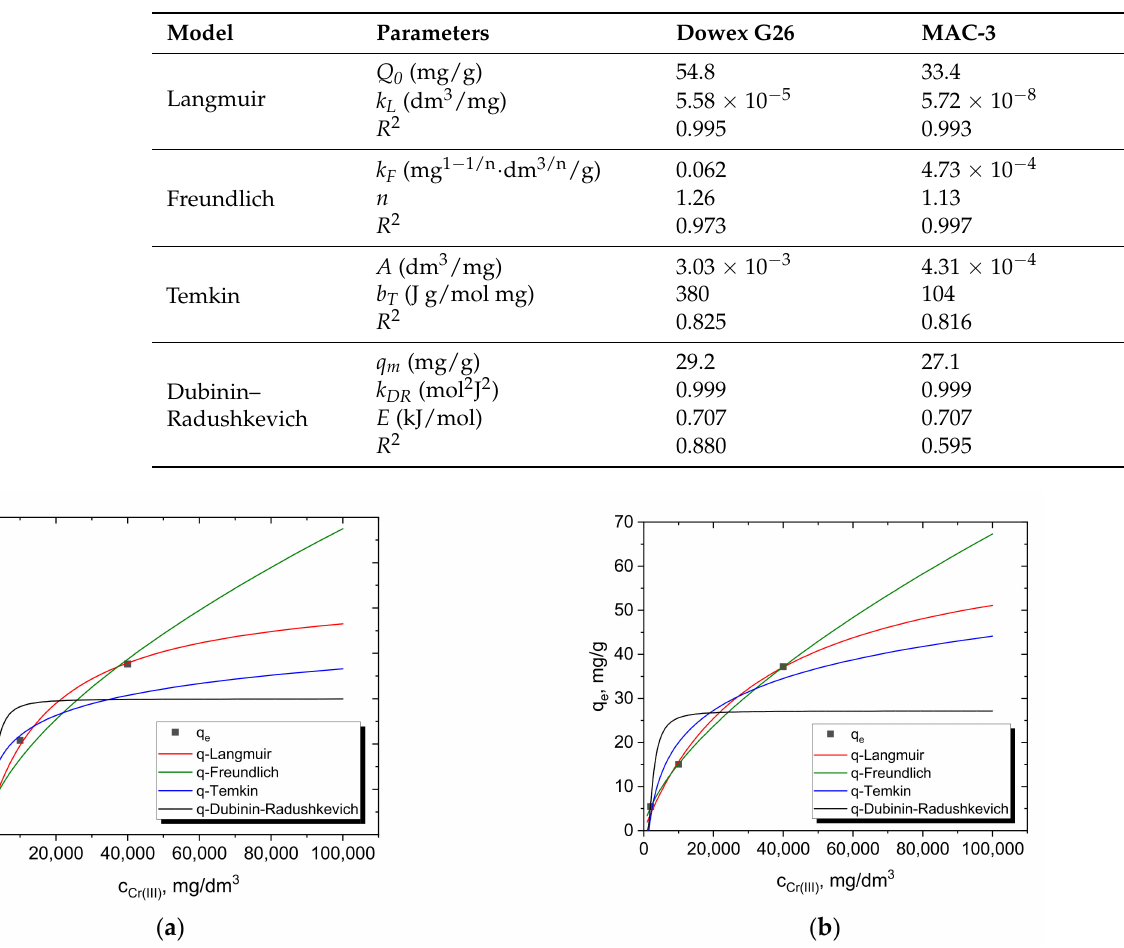
Table 3. Langmuir, Freundlich, Temkin and Dubinin–Radushkevich adsorption isotherm parameters.